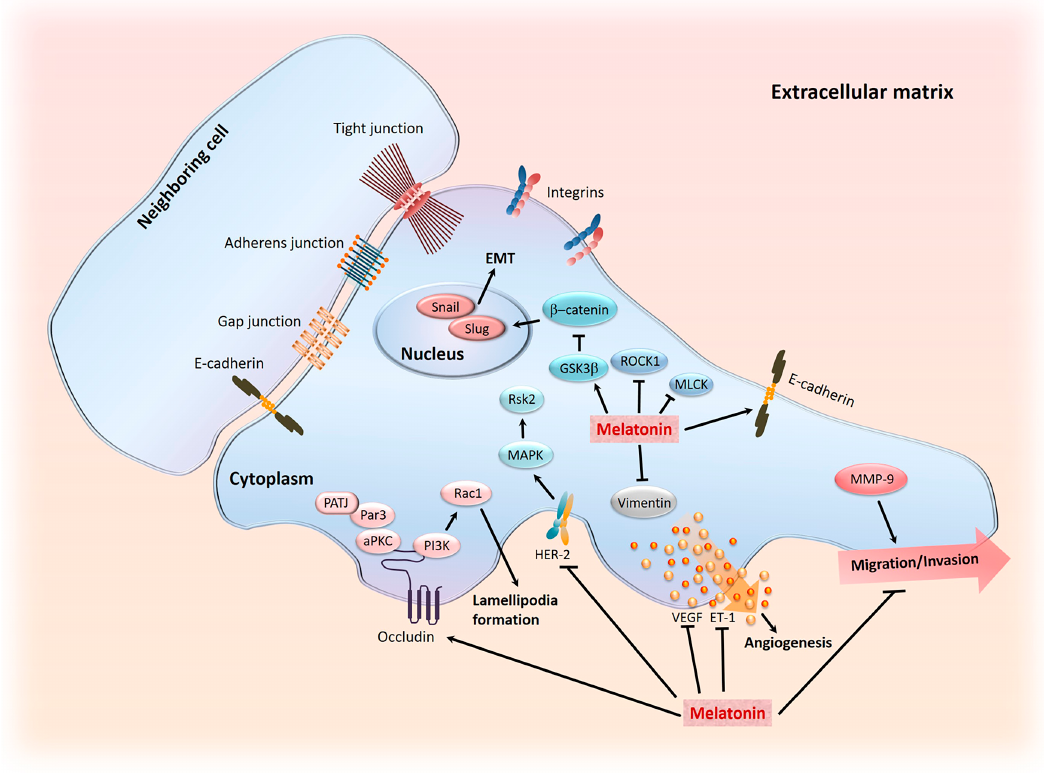
Figure 8. Schematic representation of the multiple mechanisms involved in melatonin-mediated inhibition of cancer metastasis. EMT: Epithelial-mesenchymal transition; ET1: Endothelin-1; GSK3 β : Glycogen synthase kinase 3 β ; HER-2: Human epidermal growth factor receptor-2; MAPK: Mitogen- activated protein kinase; MLCK: Myosin light-chain kinase; MMP-9: Matrix metalloproteinase-9; ROCK1: Rho-associated protein kinase 1; VEGF: Vascular endothelial growth factor.